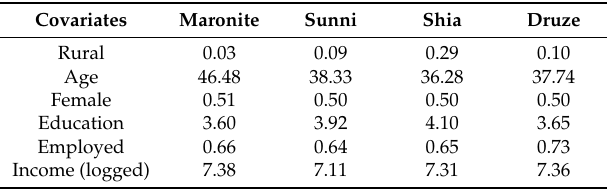
Table 3. Mean Socioeconomic Descriptive Statistics by